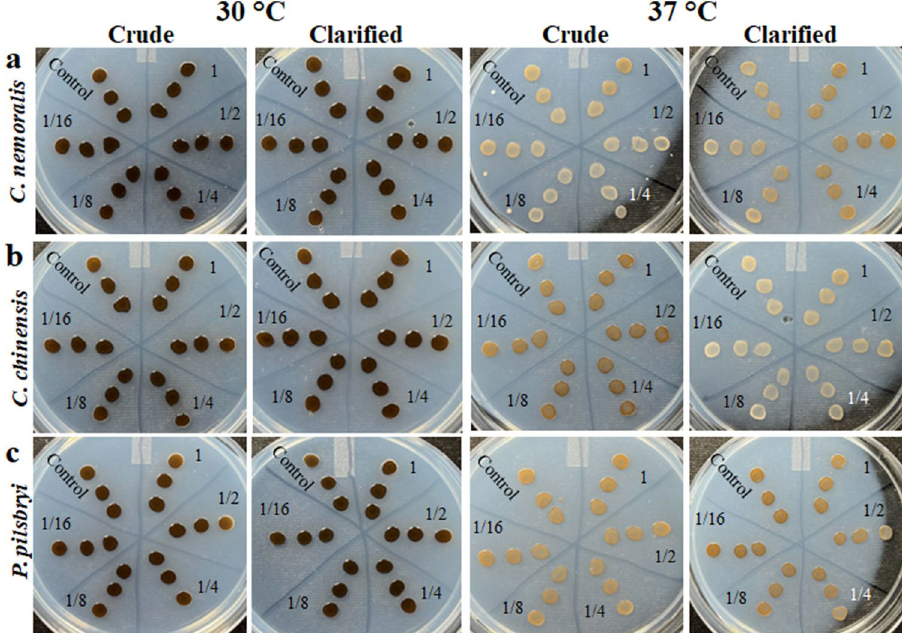
Figure 5. Effect of mollusk extracts on melanin production of C. neoformans at 30 °C and 37 °C. Row ( a ) C. nemoralis crude extracts (starting concentration: 2.1 mg/mL) and clarified (starting concentration: 0.6 mg/mL). Row ( b ) C. chinensis crude extracts (starting concentration: 1.5 mg/mL) and clarified (starting concentration: 0.4 mg/mL). Row ( c ) P. pilsbryi crude extracts (starting concentration: 0.5 mg/mL) and clarified (starting concentration: 0.3 mg/mL). For control, only PBS (pH 7.3) was spread on the plate. Images were taken after 48 h of incubation at each temperature. Experiment performed in biological triplicate and technical duplicate.